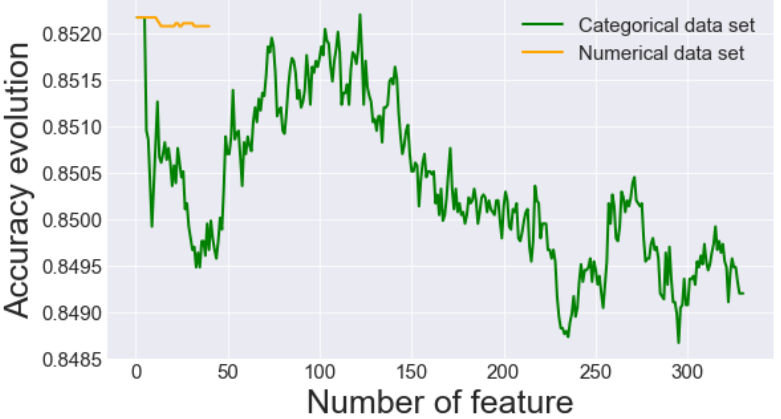
Figure 4. Evolution of accuracy and number of features.